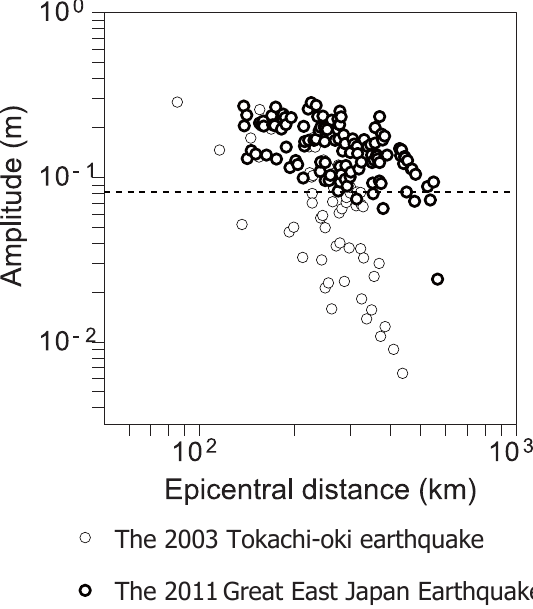
Figure 4. Amplitude data distribution of the 2003 Tokachi-oki earthquake and the 2011 Great East Japan Earthquake. The dashed line indicates the threshold